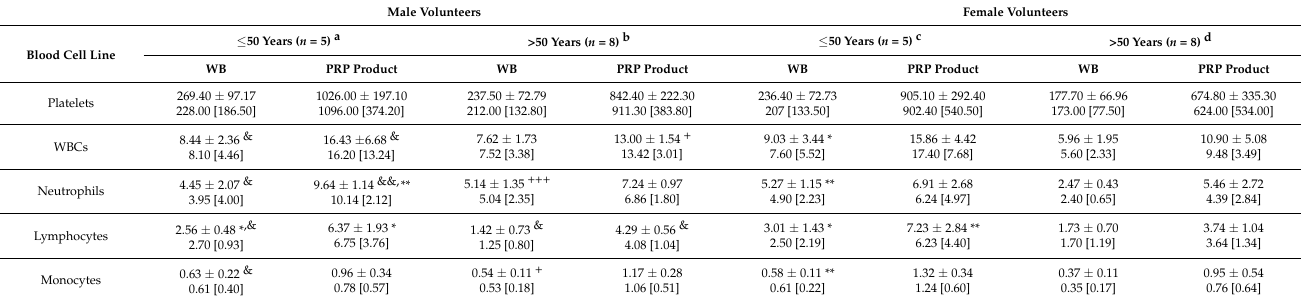
Table 2. Blood cell counts (mean cells × 10 6 /mL ± SD; median [IQR]) in WB and in the final product in male and female volunteers according to age-based breakpoint. MaleVolunteers